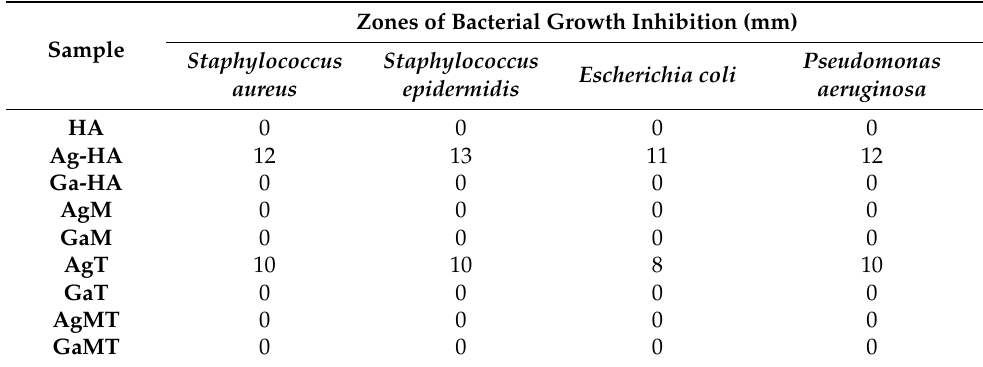
Table 5. Results of agar plate test. Diameter of the well drilled in agar medium: 7.5 mm.